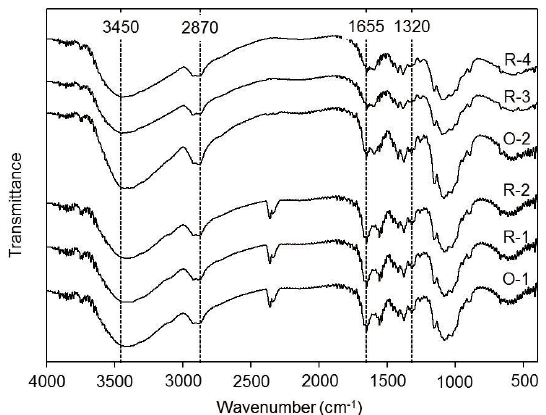
Figure 2. Fourier transform infrared spectra (FTIR) of chitosans and regenerated chitosans. Samples O-1, R-1, R-2, O-2, R-3, and R-4, respectively, are described in Table